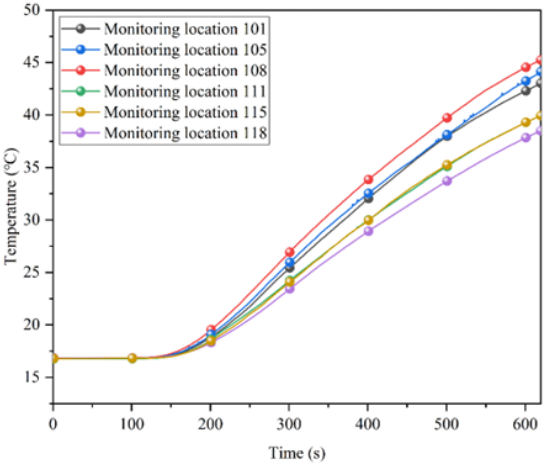
Figure 5. Partially insulated tunnel monitoring-point temperatures.